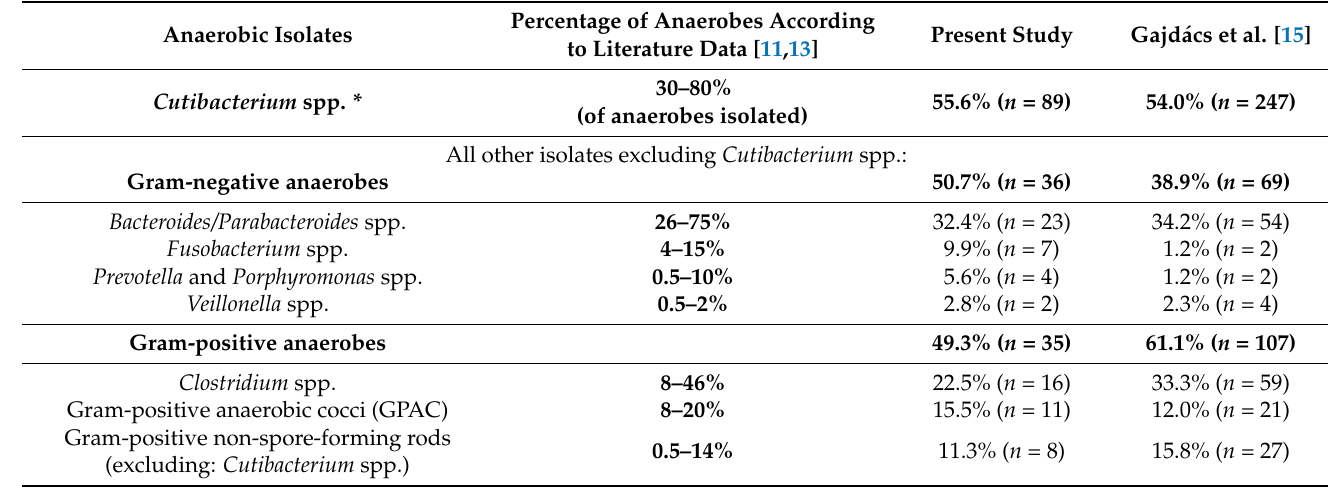
Table 4. Percentage distribution of anaerobes in the two respective studies and in comparison with the literature